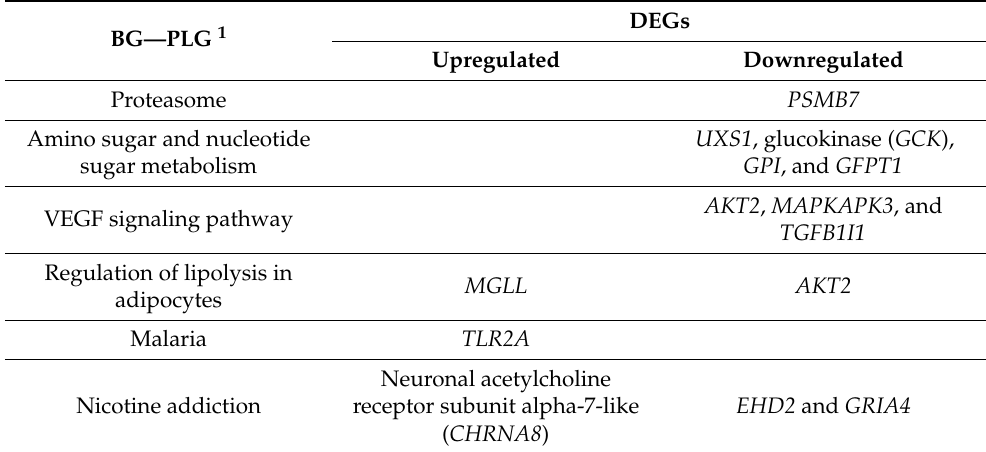
Table 2. DEGs enriched in KEGG pathways in the BG and the PLG.